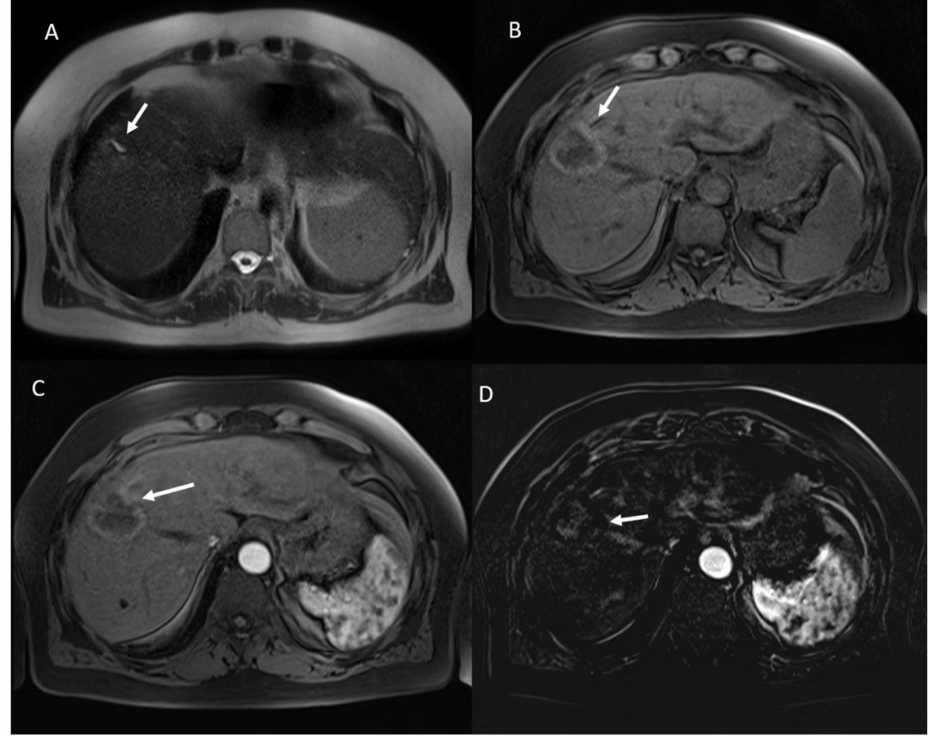
Figure 6. Non-viable treated HCC. In T2-W sequences ( A ) the arrow shows isointense SI of ablated area, with targetoid appearance in T1-W sequence, due to peripheral hypintense rim ( B ). Post-contrast arterial phase ( C ) analysis in subtraction ( D ) shows no